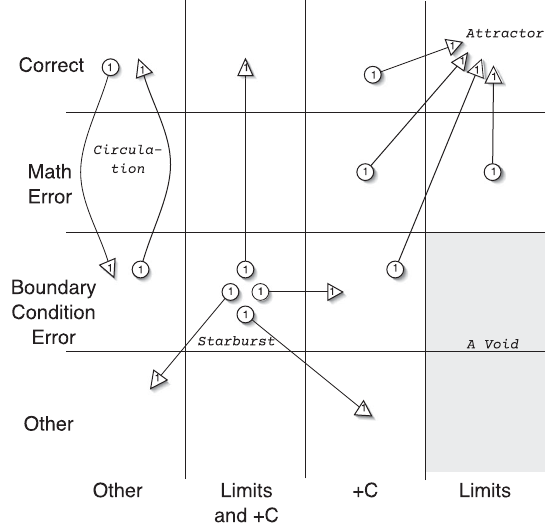
FIG. 9. Circulation pattern representing a subset of data from Fig. 7. Students flow out of and into matched regions on the consistency